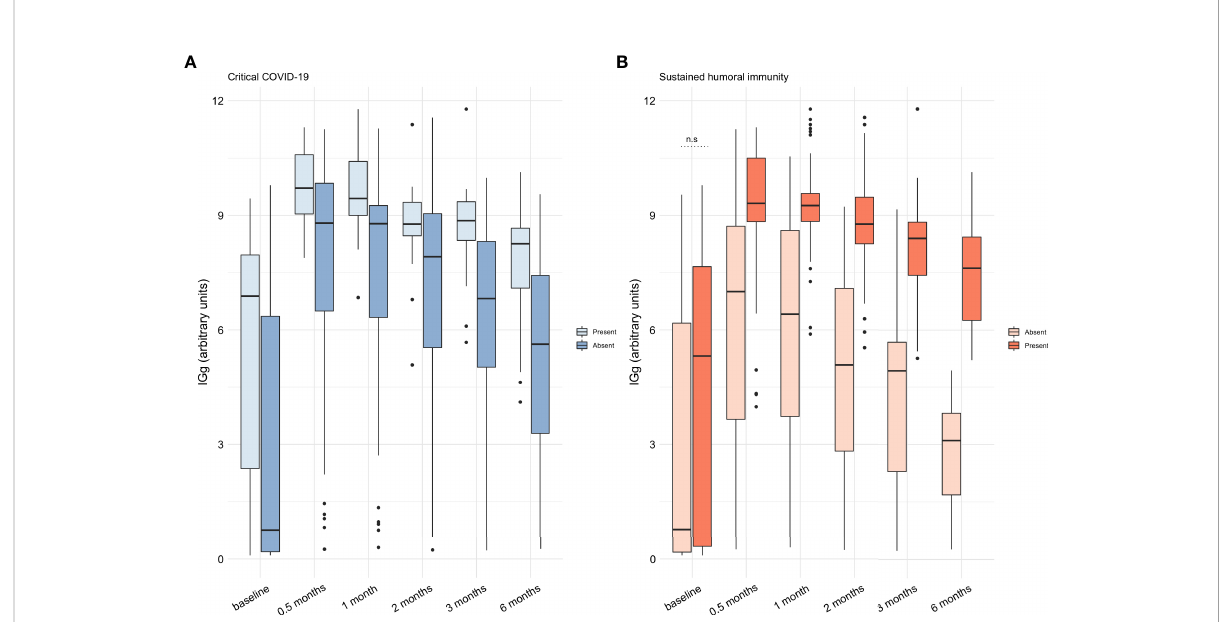
FIGURE 1 Assessment of the anti-SARS-CoV-2 IgG throughout time in the cohort of patients from mild to critical COVID-19. (A) The titers of anti-SARS- CoV-2 IgG was higher at all timepoints in patients with critical COVID-19 (P<0.05). (B) Patients with a sustained humoral immune response had a higher amount of anti-SARS-CoV-2 IgG at all timepoints (P<0.05) but not at baseline (n.s.). Anti-SARS-CoV-2 IgG titers are expressed as medians with interquartile range and were compared with the Wilcoxon test. AU: arbitrary units; IgG: immunoglobin G; SARS-CoV-2: severe acute respiratory syndrome coronavirus 2. n.s: non-signi fi